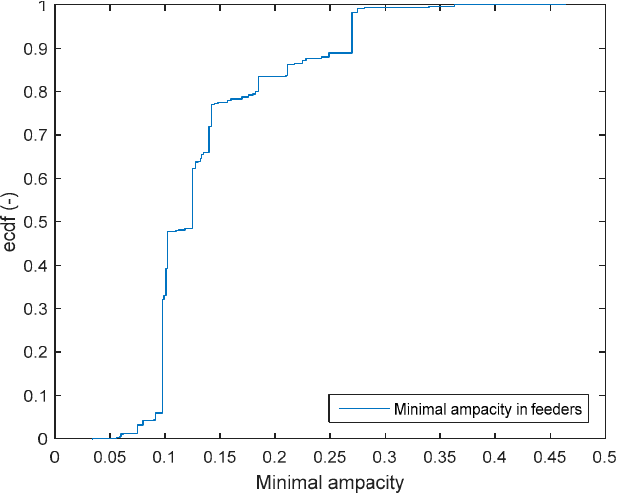
Figure 11. Ecdf of the minimal ampacity of feeders.